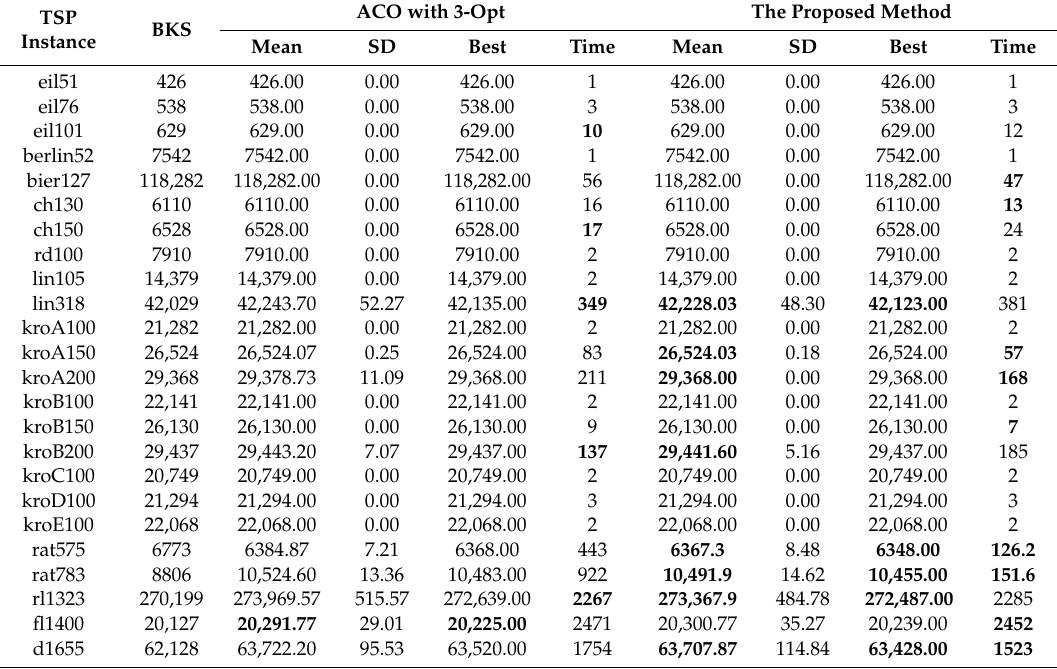
Table 2. Experimental results of ACO and